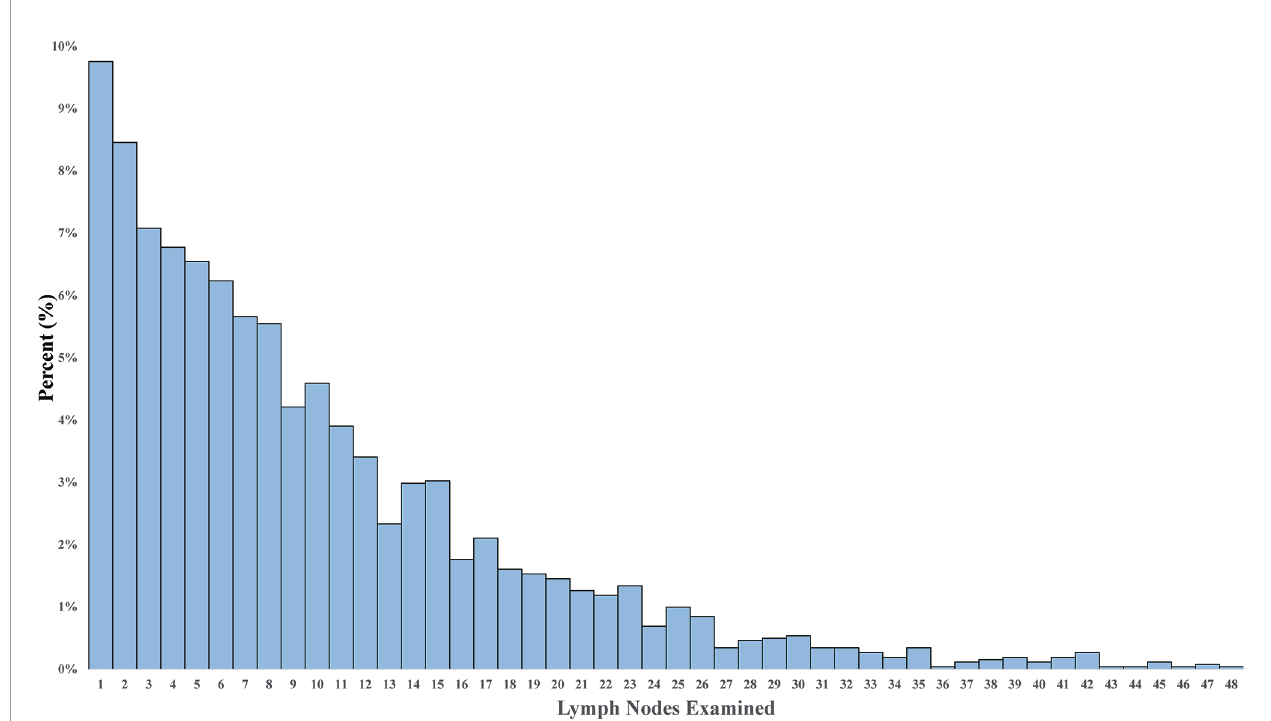
FIGURE 1 | The distribution of lymph nodes examined in stage IV non – small cell lung cancer patients with lymph node